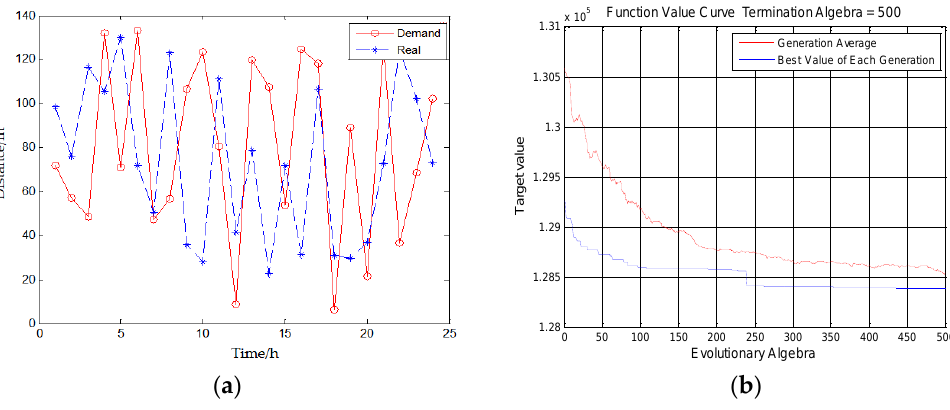
Figure 12. Experimental results: ( a ) optimization variable result; ( b ) optimization function result.